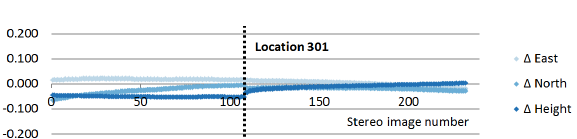
Figure 13. Deviations of projection centers in m for sequence 3.1